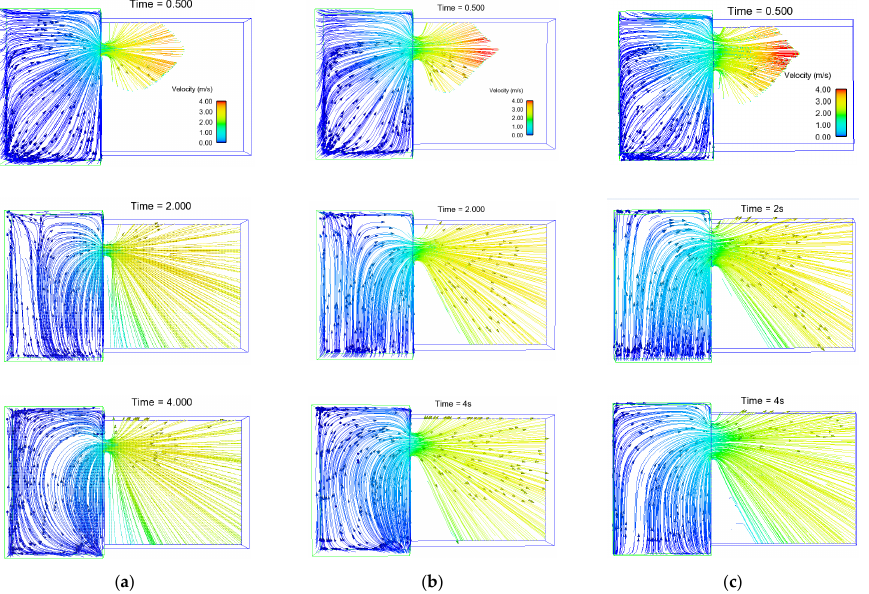
Figure 5. Streamline of magnitude velocity at different time in 3 models: ( a ) 7A, ( b ) 8A, ( c ) 9A.